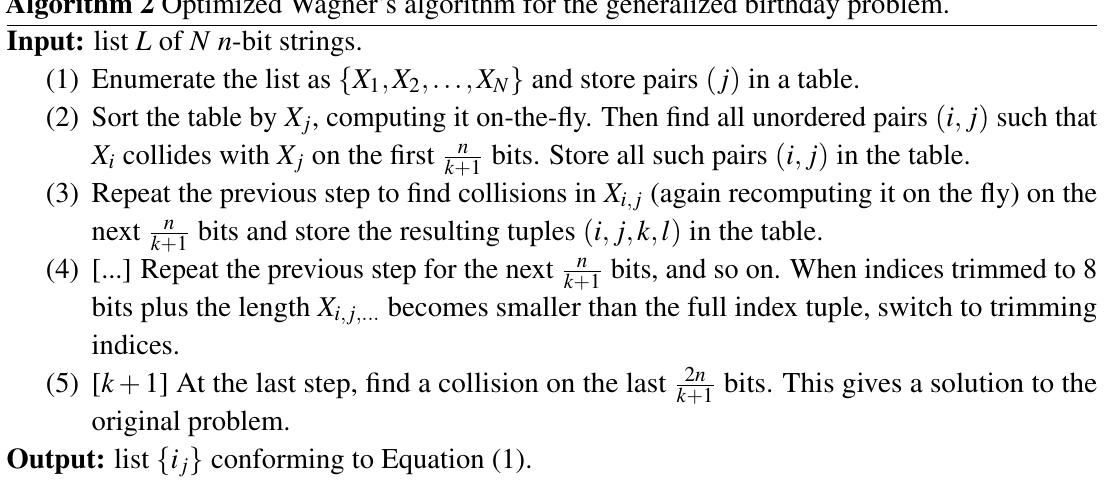
Algorithm 2 Optimized Wagner’s algorithm for the generalized birthday problem. Input: list L of N n -bit